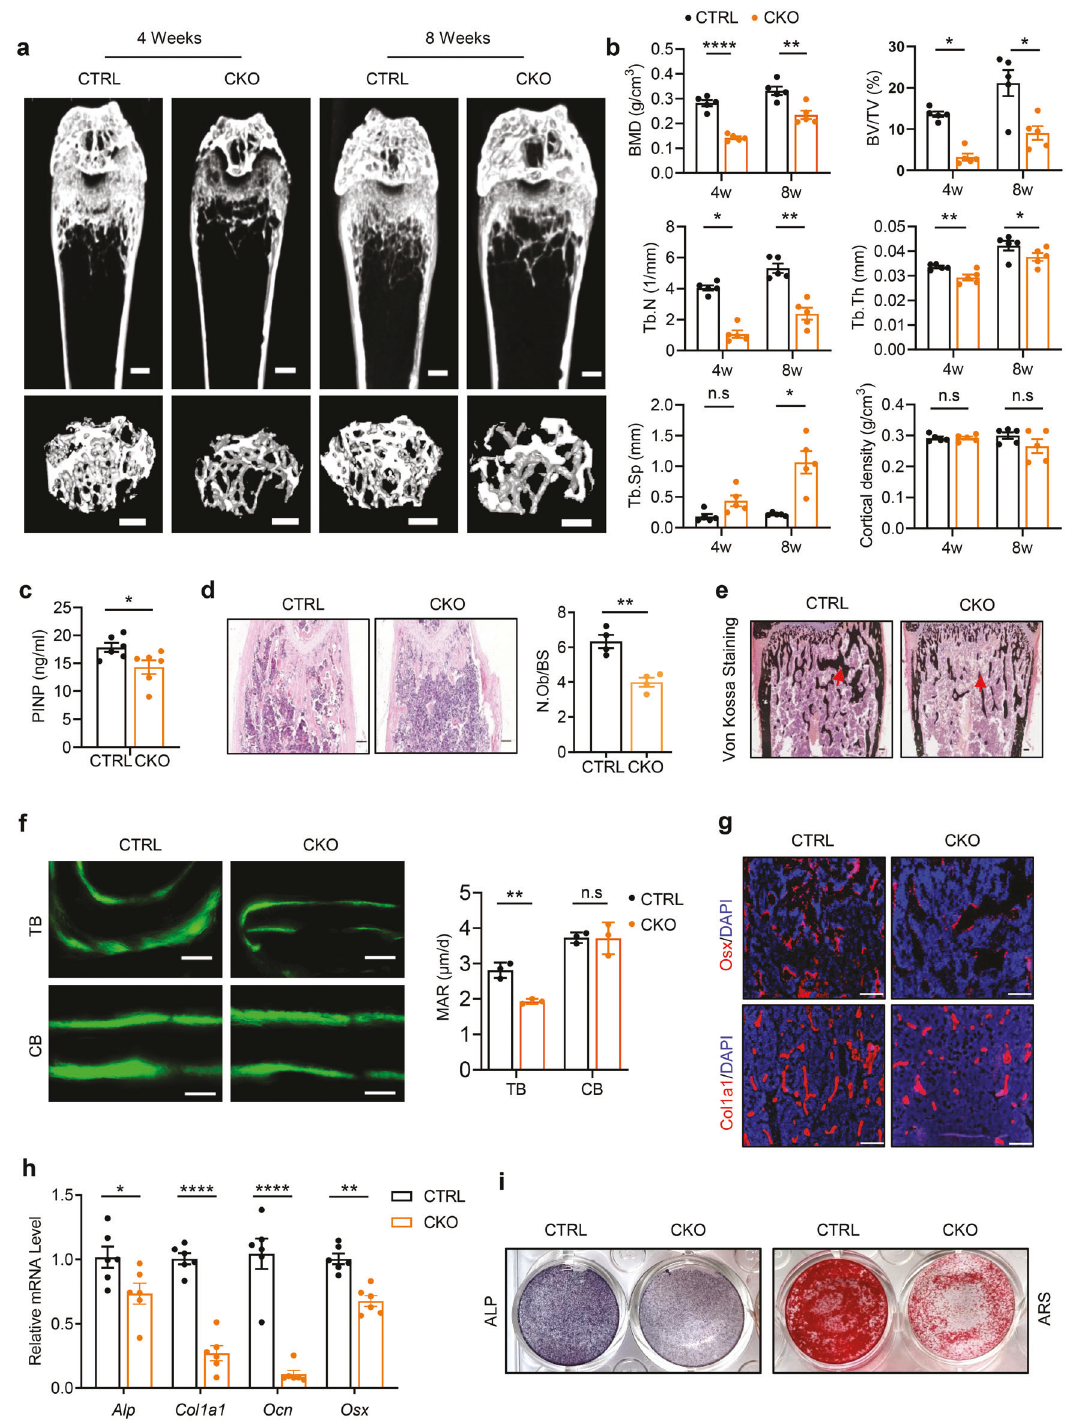
kinases-related pathway (Supplementary Fig. 3c). Therefore, we analyzed the expression of FGFRs in Otub1 deleted cells. As shown in Fig. 3c, d, among FGFRs, FGFR2 protein levels were signi fi cantly decreased. Notably, OTUB1 de fi ciency did not affect the FGFR2 transcriptional level (Supplementary Fig. 3d). Consistently, the depletion of OTUB1 led to delayed activation of AKT and